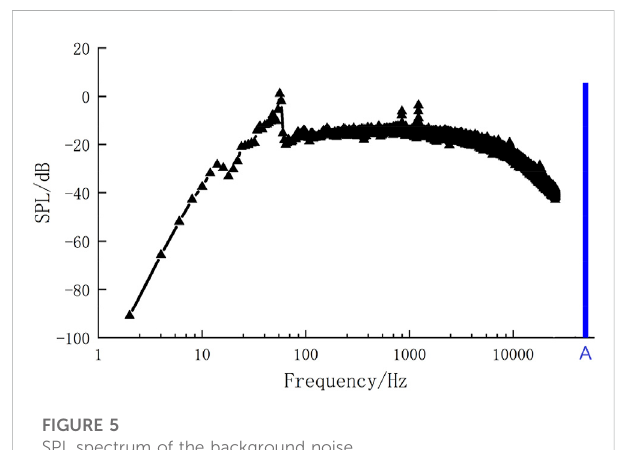
FIGURE 5 SPL spectrum of the background